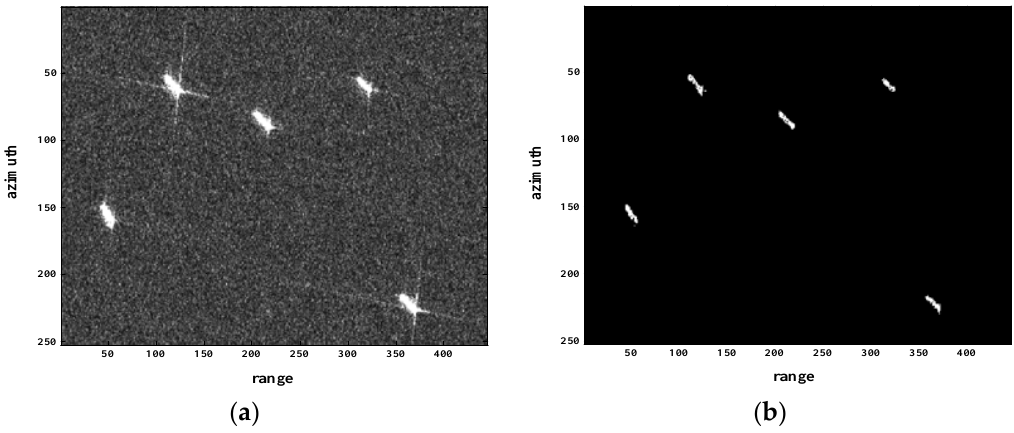
Figure 8. Processing result of GF-3 image around Tianjin Harbor. ( a ) GF-3 image around Tianjin harbor; ( b ) Reconstructed GF-3 image through the proposed method. A full-polarization GF-3 pseudo-color image of the Indian Ocean is displayed in Figure 9a. The pseudo-color image is formed by the fusion of HH, HV and VV polarization channel SAR images.